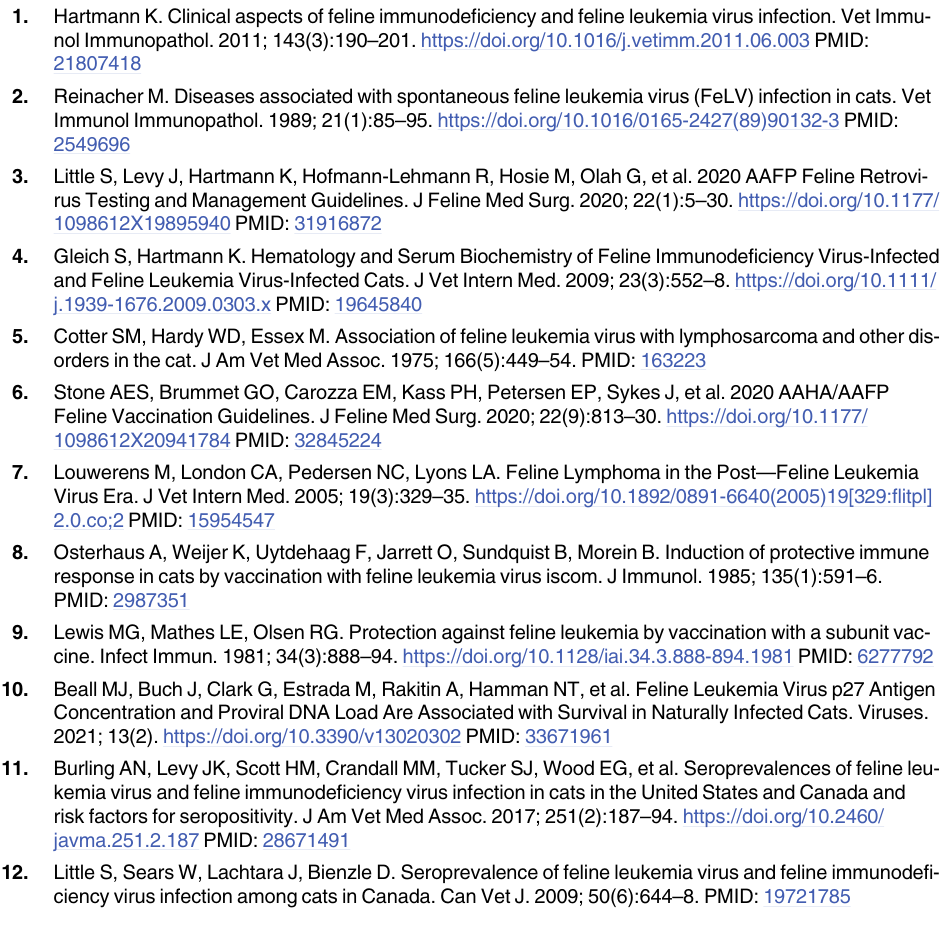
S2 Fig. CBC results. HCT: Hematocrit, MCV: Mean corpuscular value, NRBC: Nucleated red blood cells, WBC: White blood cells. (XLSX) S3 Fig. Chemistry results. CK: Creatine kinase, AST: Aspartate aminotransferase, ALT: Ala- nine aminotransferase, ALP: Alkaline phosphatase, TT4: Total thyroxine.